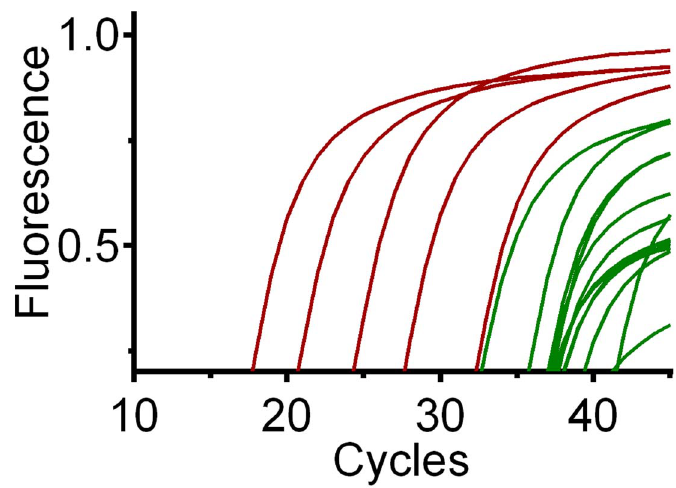
Figure 4. Chicken qPCR amplification of 14 samples (green), 5 serial dilutions (red) and NTC (no template control, black). NTC are not visible because they did not amplify and rise above the X-axis.